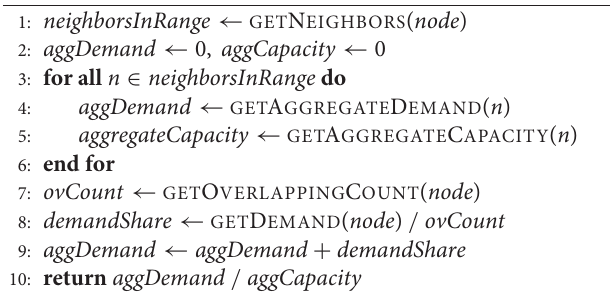
Algorithm 1 CapacityDemandRatio( node